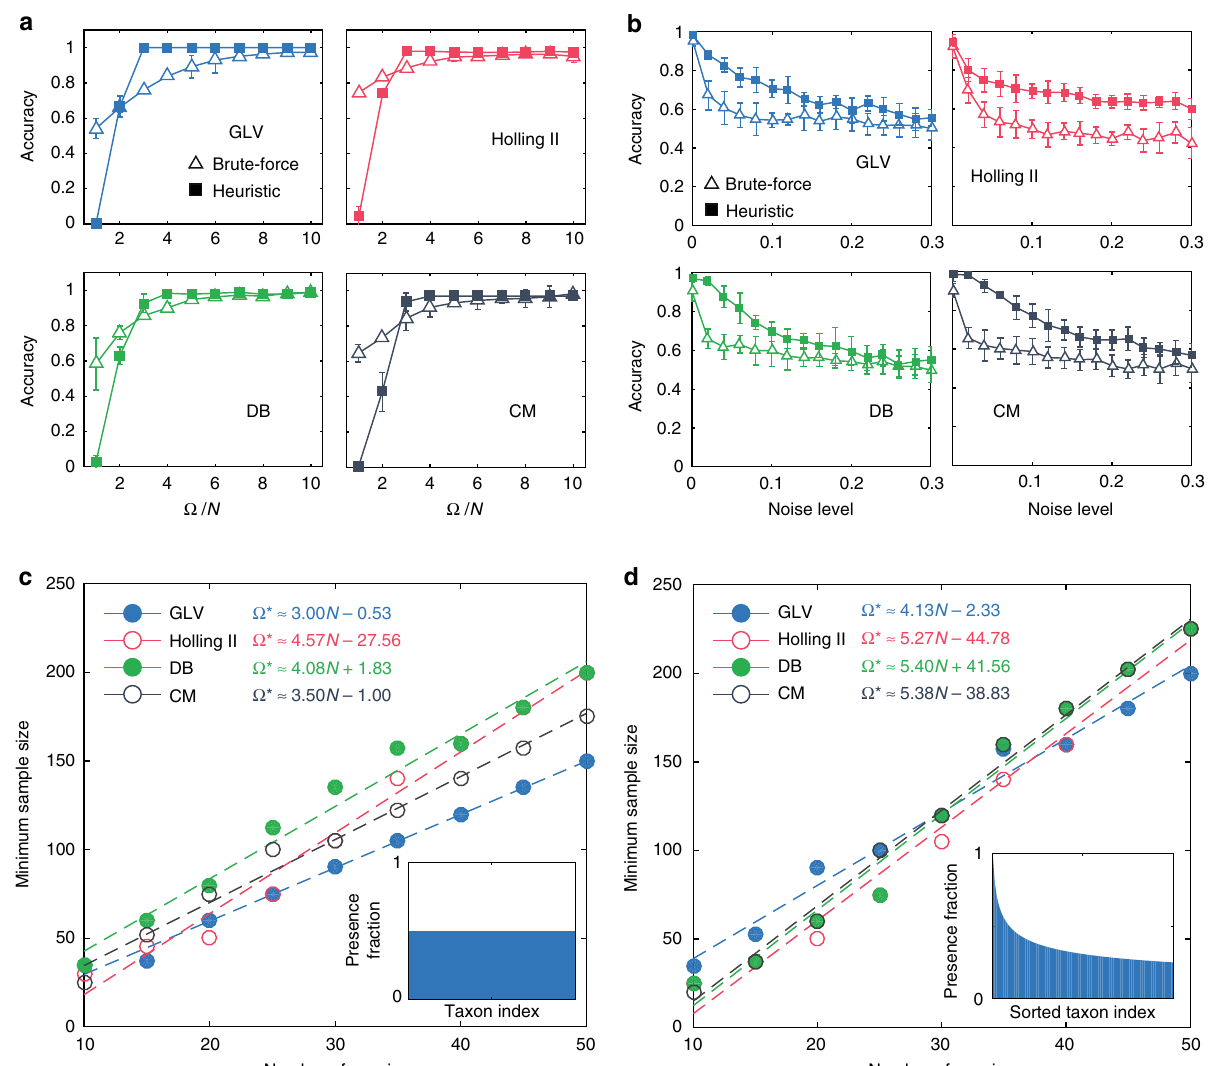
Fig. 3 Validation of our method in inferring interaction types using simulated data. a , b Consider a small microbial community of N ¼ 8 taxa. We generate steady- state samples using four different population dynamics models: Generalized Lotka – Volterra (GLV), Holling Type II (Holling II), DeAngelis – Beddington (DB), and Crowley – Martin (CM). We compare the performance of the brute-force algorithm (with solution space ~3 8 ¼ 6 ; 561) and the heuristic algorithm (with solution space ~ Ψ ¼ 5 N ¼ 40). a In the noiseless case, we plot the inference accuracy (de fi ned as the percentage of correctly inferred signs in the Jacobian matrix) as a function of sample size Ω . b In the presence of noise, we plot the inference accuracy as a function of the noise level η . Here the sample size is fi xed: Ω ¼ 5 N ¼ 40. The error bar represents standard deviation for 10 different realizations. c , d We calculate the minimal sample size Ω (cid:2) required for the heuristic algorithm to achieve high accuracy (100% for GLV, 95% for Holling II, DB, and CM) at different system sizes. We consider two different taxa presence patterns: uniform and heterogenous (see insets). Here the simulated data is generated in the noiseless case and we chose Ψ ¼ 10 N . a – d The underlying ecological network is generated from a directed random graph model with connectivity 0.4 (i.e., with probability 0.4 there will be a directed edge between any two